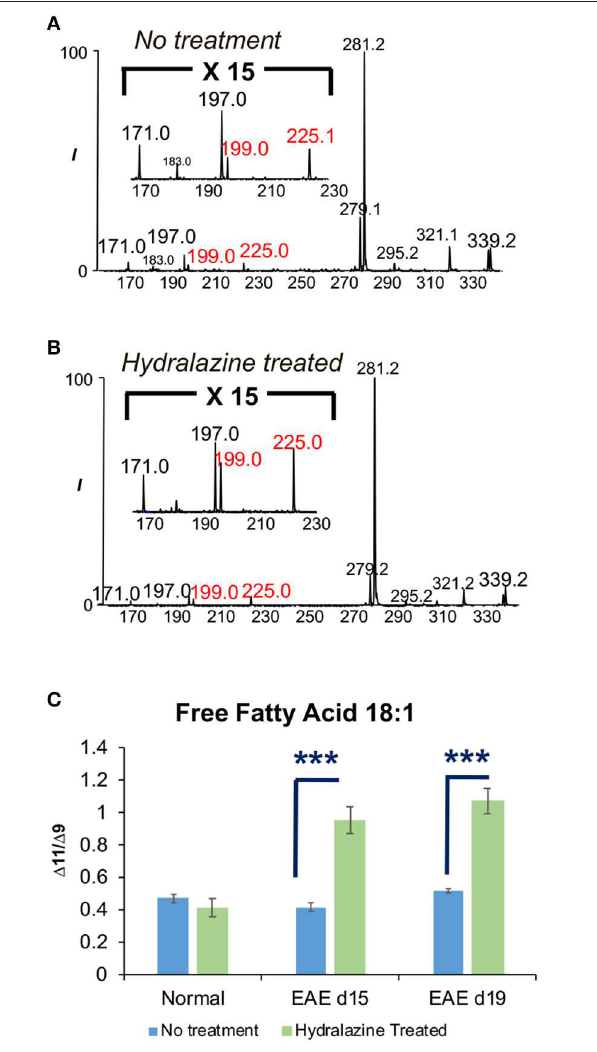
linearity of R 2 = 0.9967 and 0.9976 was obtained for FA 16:0